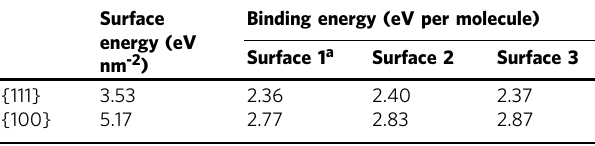
Surfaces 1 to3 have approximatevalues of bindingenergies,so we have used the average of the two values in the text, i.e., 2.37eV for {111} surfaces and 2.82eV for {100} surfaces a Surfaces 1 to 3 correspond to the three con fi gurations shown in Fig.